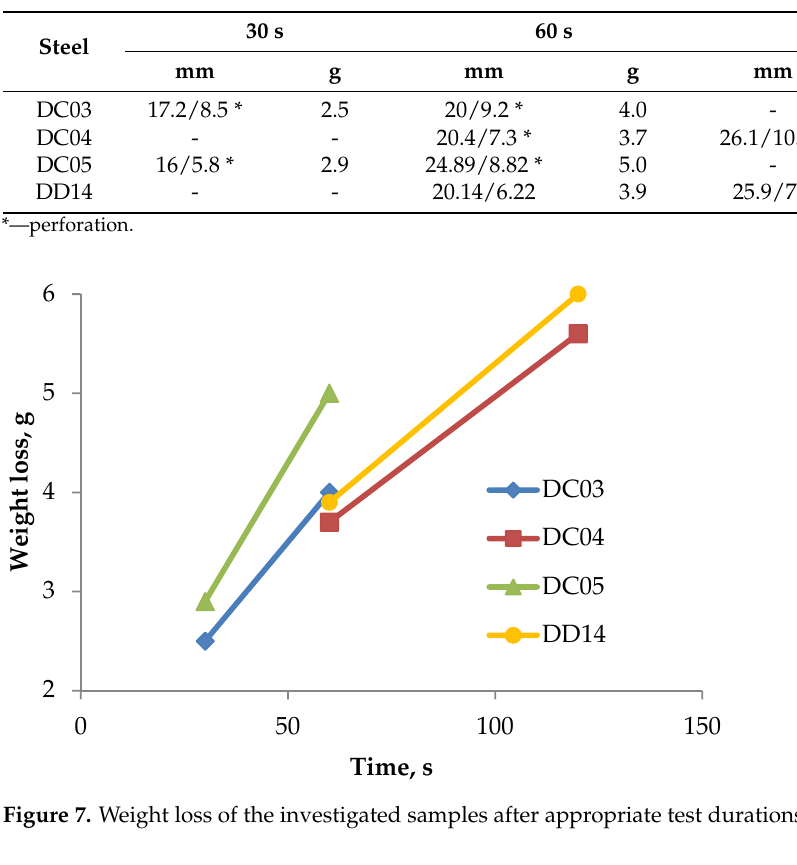
Figure 9. Crater diameter in the investigated samples Figure 10. Changes in the average material thickness of the investigated samples.